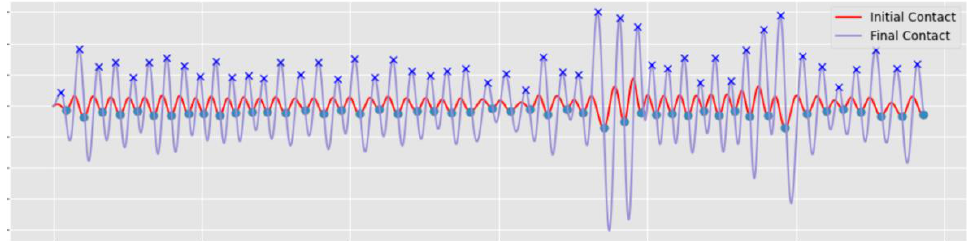
Figure 2. Example wavelet outputs from the bouts of walking captured during level ground asphalt walking phase with minima and maxima (peaks i.e., ICs and FCs) identified from CWT-based sig- nals.